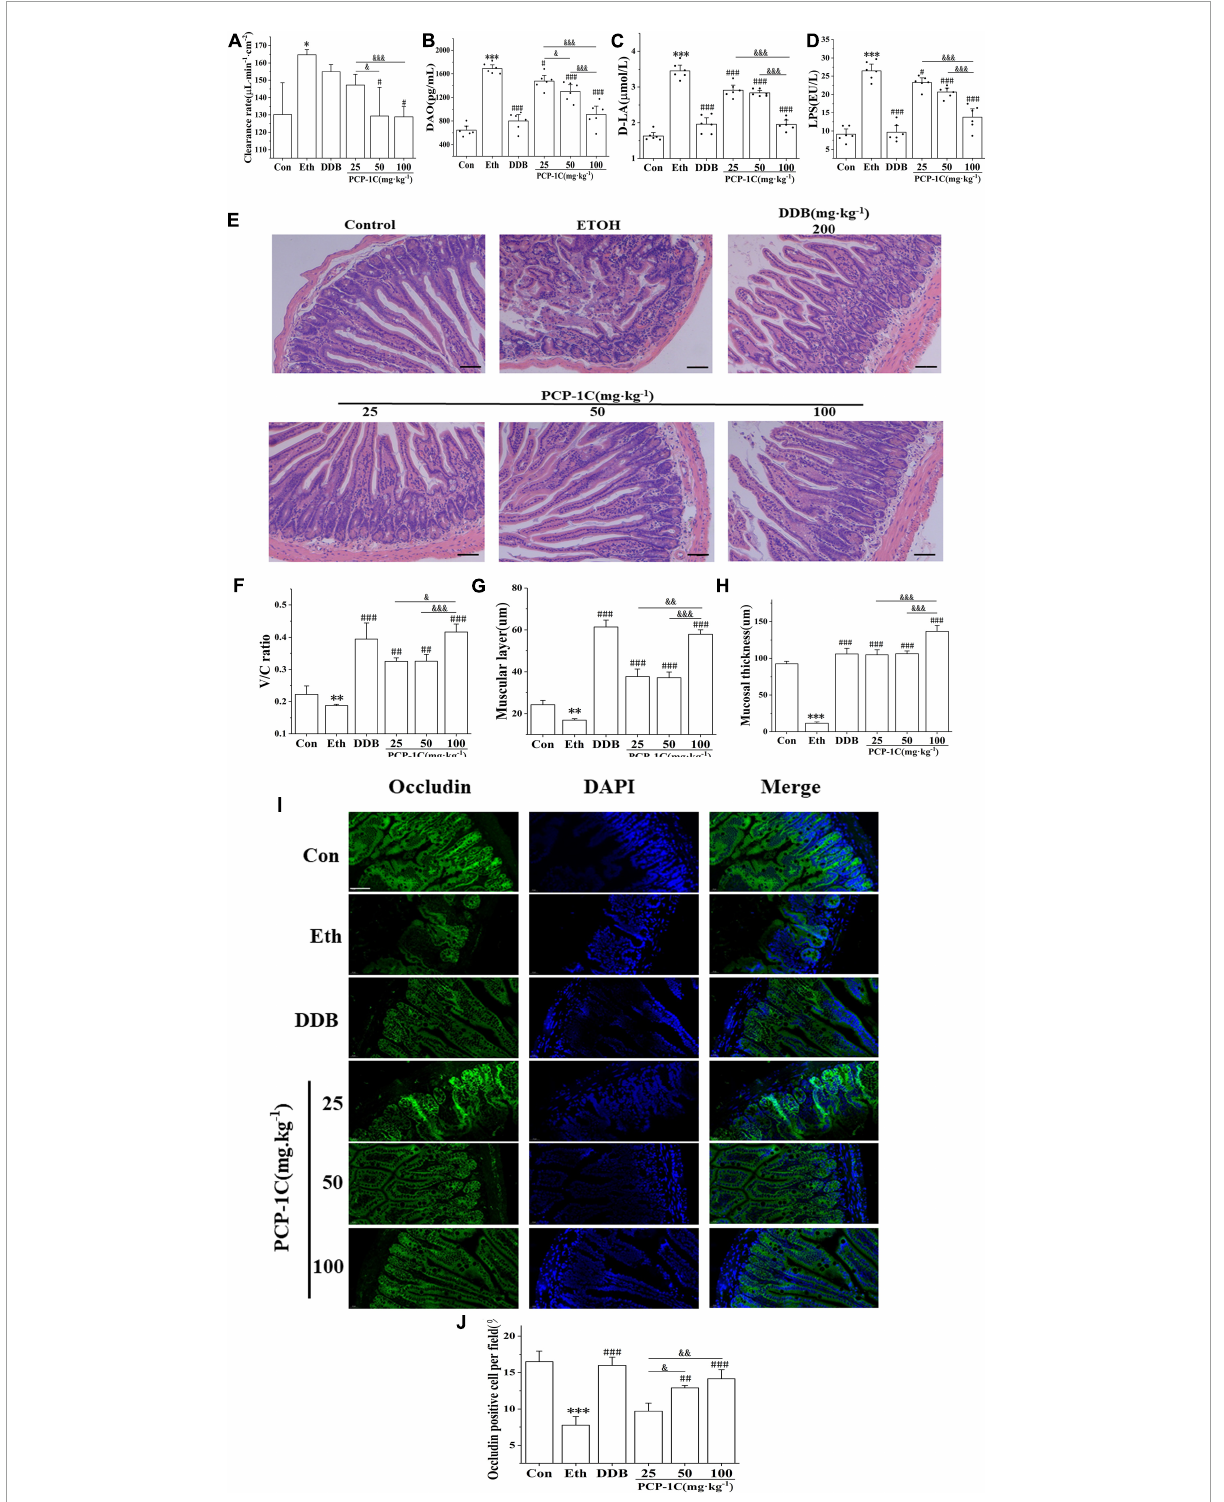
FIGURE5 Effect of PCP-1C on the intestinal barrier injury in ALD mice. (A) The clearance rate of ileum per unit area in mice. (B) Serum levels of DAO, (C) D-La and (D) LPS, (E–H) H&E staining of the ileum. (I,J) Immunofluorescence staining of occludin in the ileum. (Green: occludin, blue: nucleus, × 400, scale 100 µ m). The results are presented as mean ± SD ( n ≥ 6). ∗ P < 0.05, ∗∗ P < 0.01, ∗∗∗ P < 0.001, vs. the control group; # P < 0.05, ## P < 0.01, ### P < 0.001 vs. the model group. & P < 0.05, && P < 0.01, &&& P < 0.001 represents significance between PCP-1C